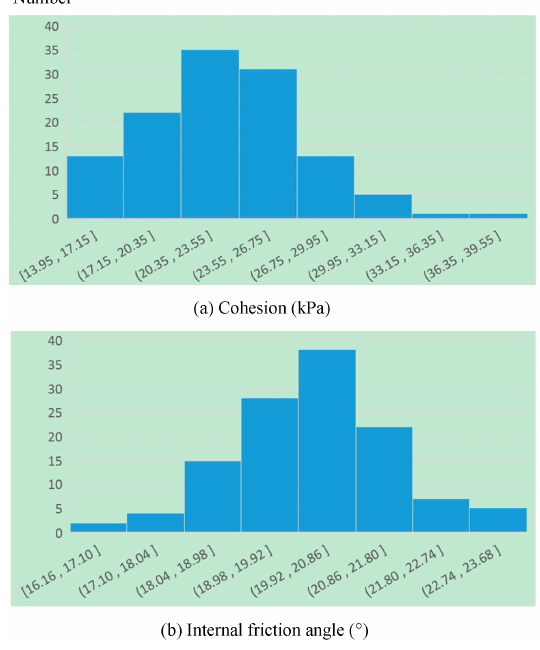
Figure 12. Histograms of fine sediment cohesion ( a ) and internal friction angle ( b ).